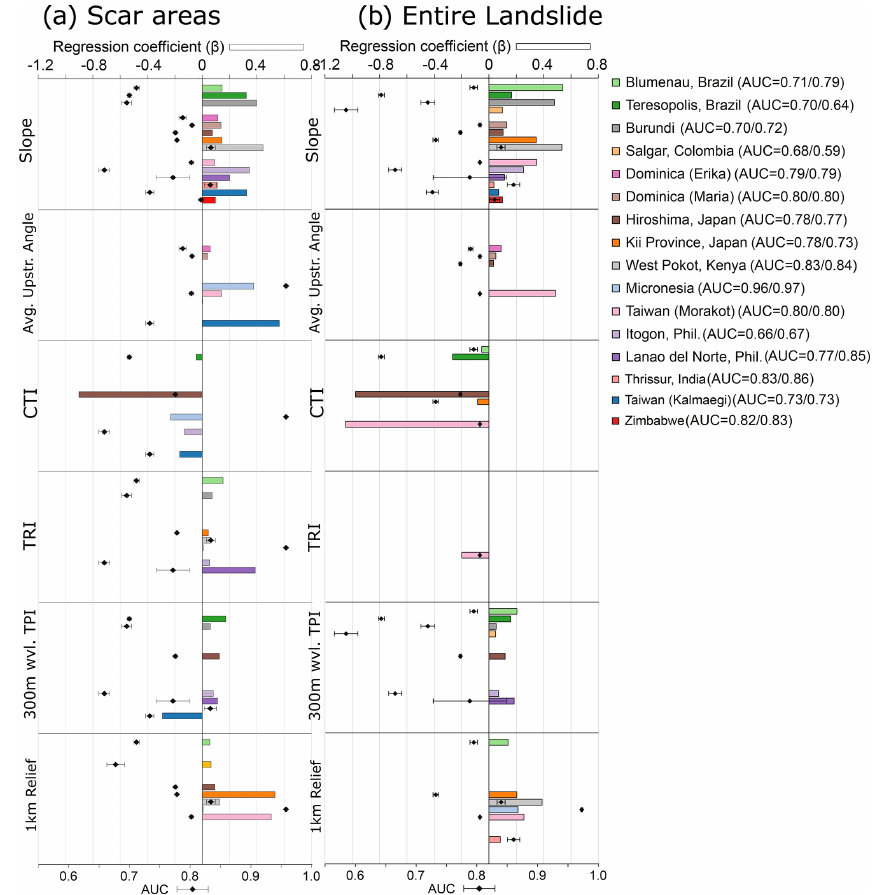
Figure 10. Figure showing regression coefficients and corresponding AUC values calculated from the fitted GLM for each landslide inven- tory, considering scars (a) or the whole landslide area (b) . The error bar corresponds to the variation in the AUC distribution across 10-fold cross-validation replicates. Regression coefficients are not shown for predictors considered not significant by the LASSO methods. The AUC values shown in the legend are for scars (prior to slash) and entire landslides (second